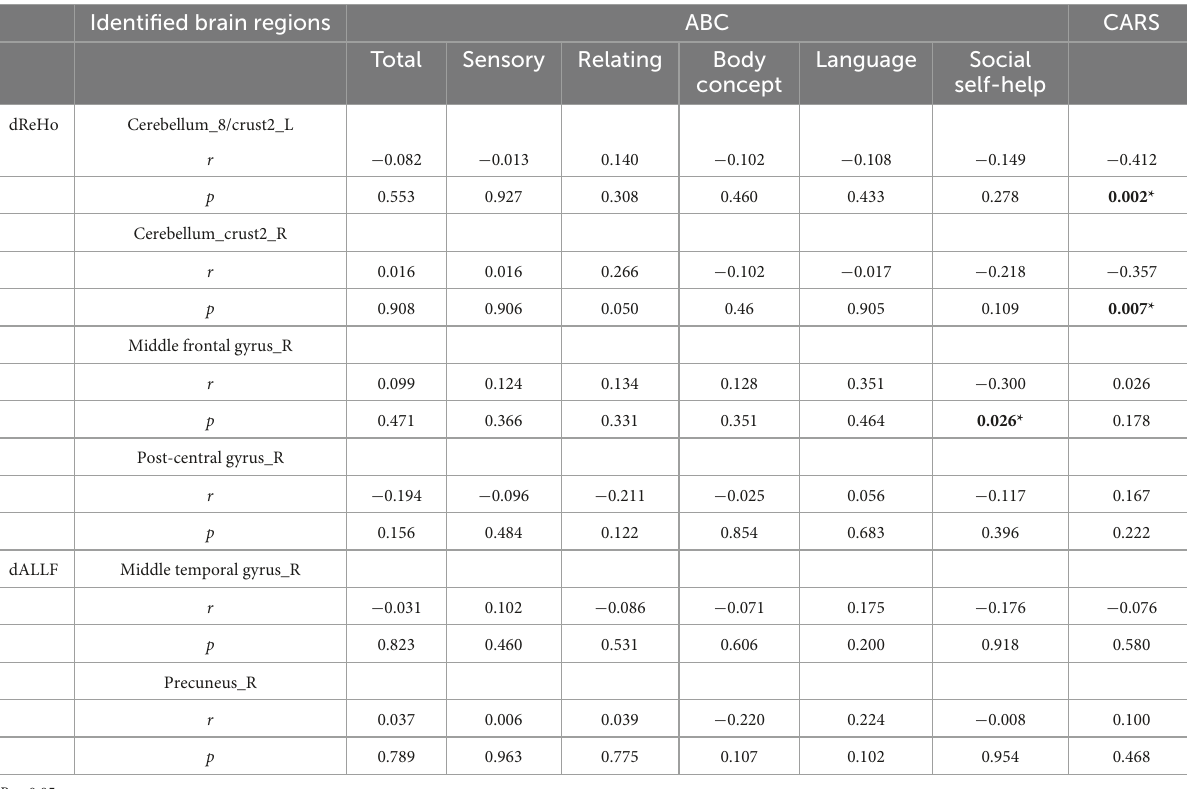
TABLE 4 Correlation between dynamic regional homogeneity/dynamic amplitude of low-frequency fluctuation (dReHo/dALFF) values and behavioral scores Autism Behavior Checklist/Childhood Autism Rating Scale (ABC/CARS) in the autism spectrum disorder (ASD) group. Identified brain regions ABC CARS Total Sensory Relating Body Language Social concept self-help